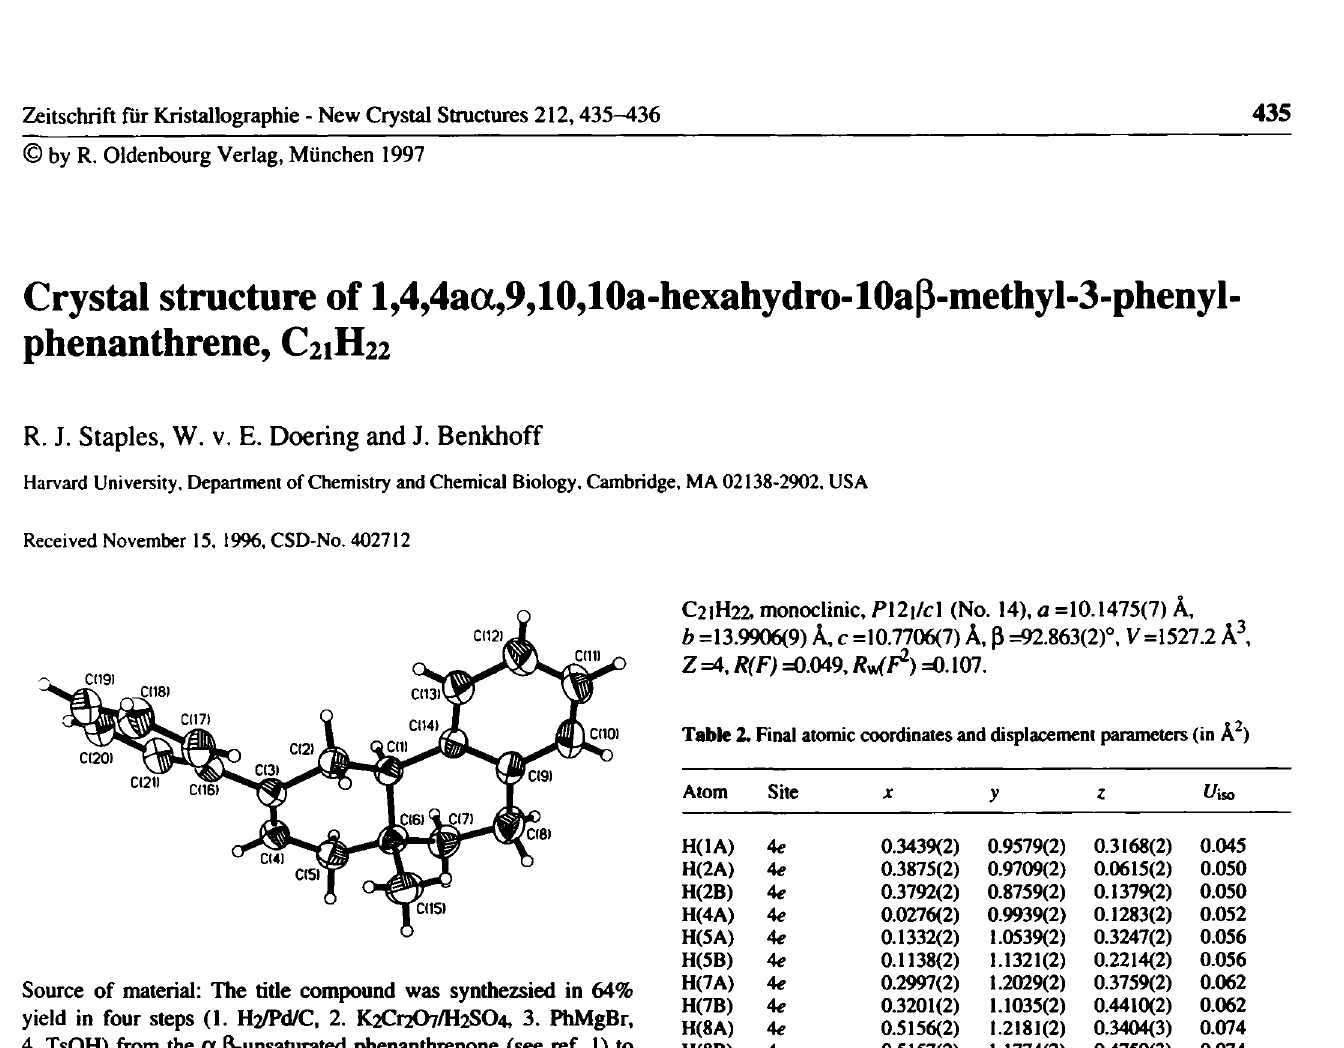
Table 1. Parameters used for the X-ray data collection